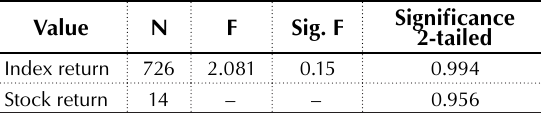
Table 2. Independent sample t-test result between average LQ 45 stock return and average